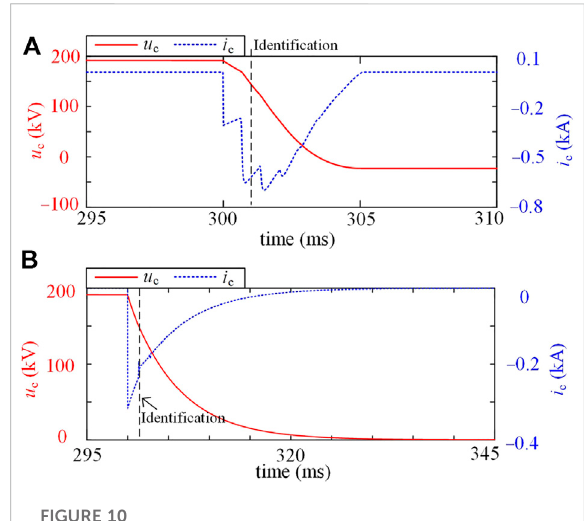
FIGURE 10 Simulation results during reclosing: (A) permanent metallic fault: (B) permanent high resistance